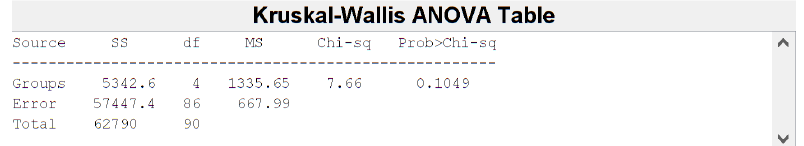
Figure 10. Kruskal-Wallis Table for the PC 2 scores. p -value = 0.1049 > 0.05.